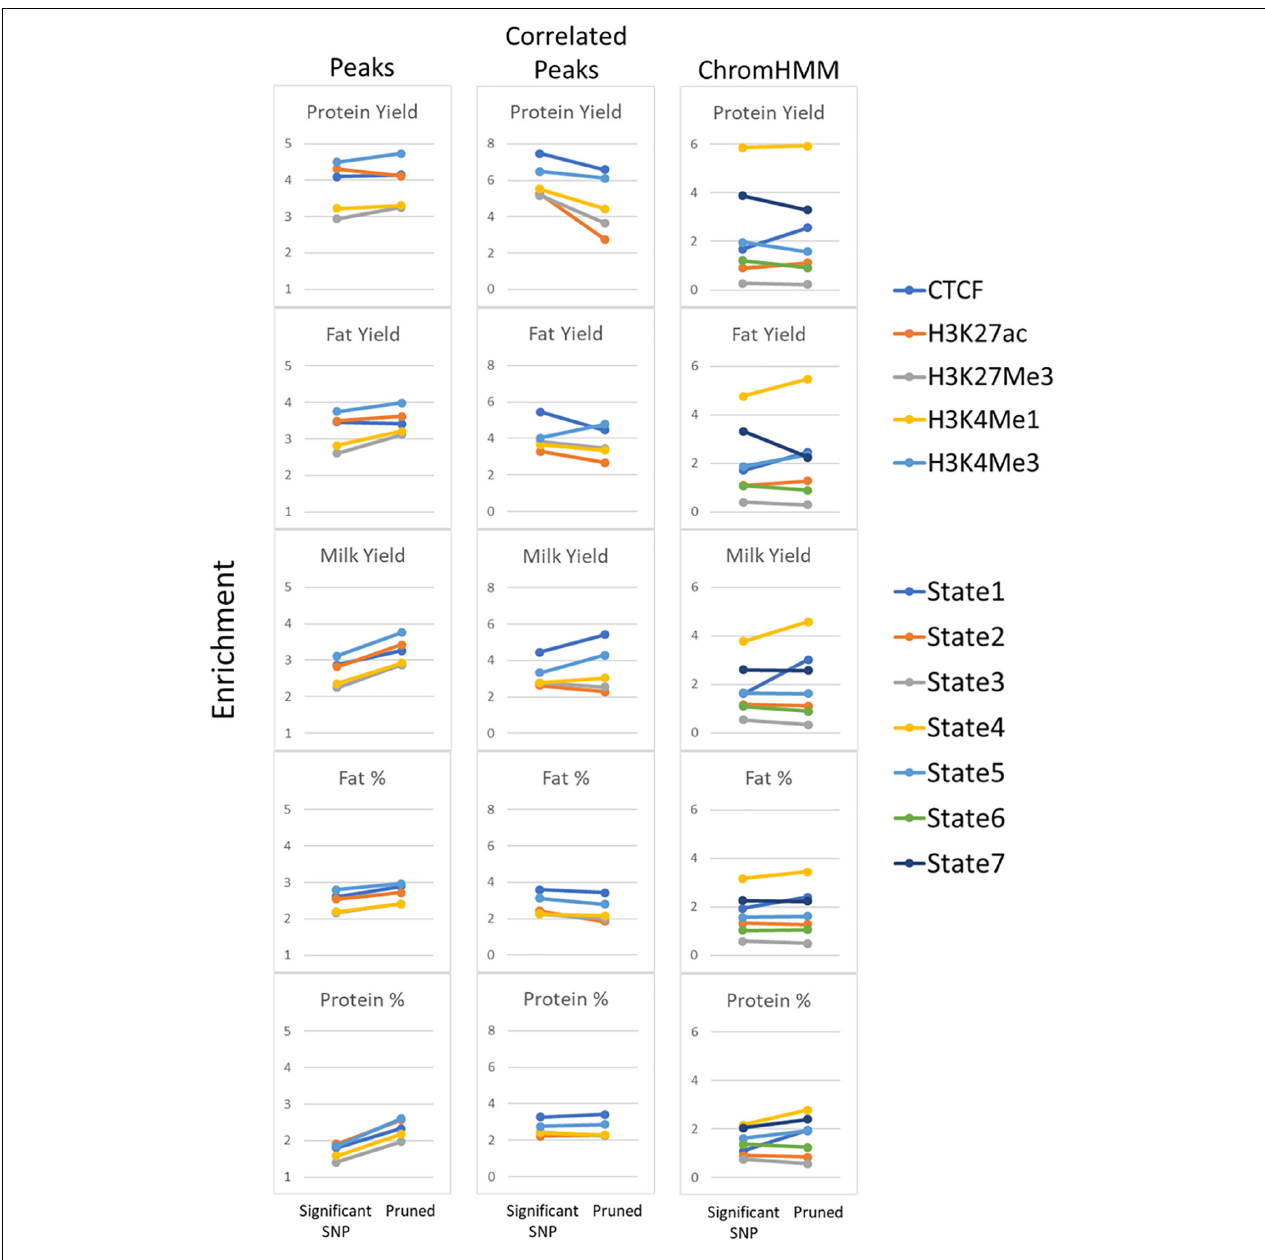
FIGURE 10 | Enrichment of pruned SNPs within functional regions. Comparison of enrichment for all significant milk production QTL ( P < 1 × 10 − 7 ) compared with pruning SNPs at r 2 < 0.5. All peaks and peaks correlated with gene expression (Correlated Peaks) for all 5 traits are shown as well as ChromHMM